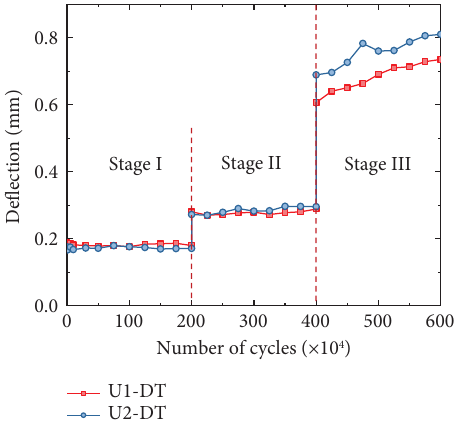
Figure 12: Strain distribution in rib-to-deck joint versus number of cycles.